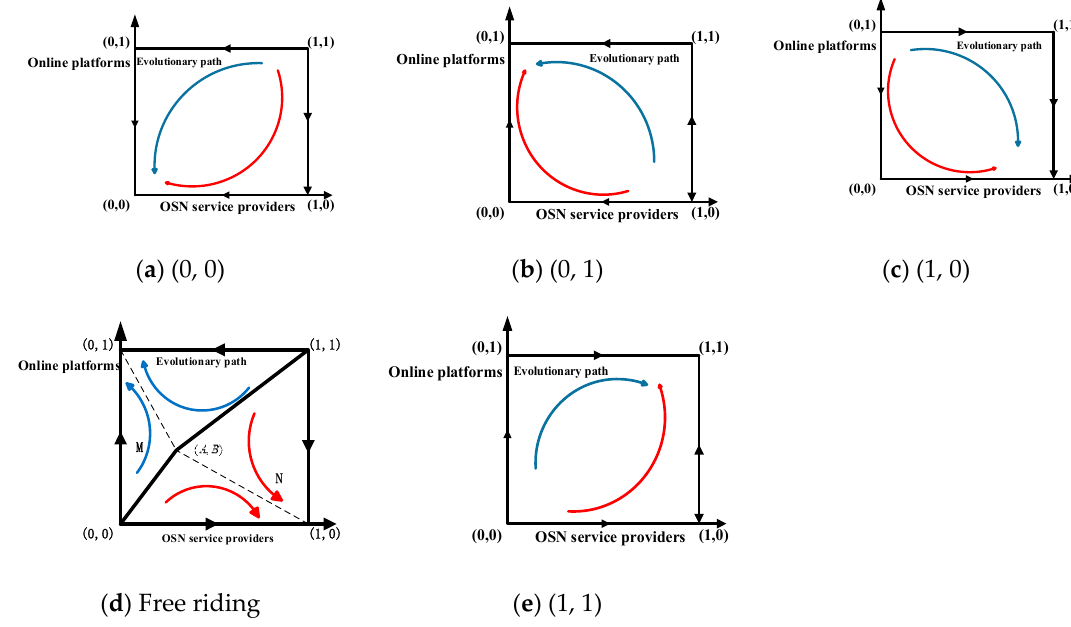
Figure 1. Evolution of the dynamic model.